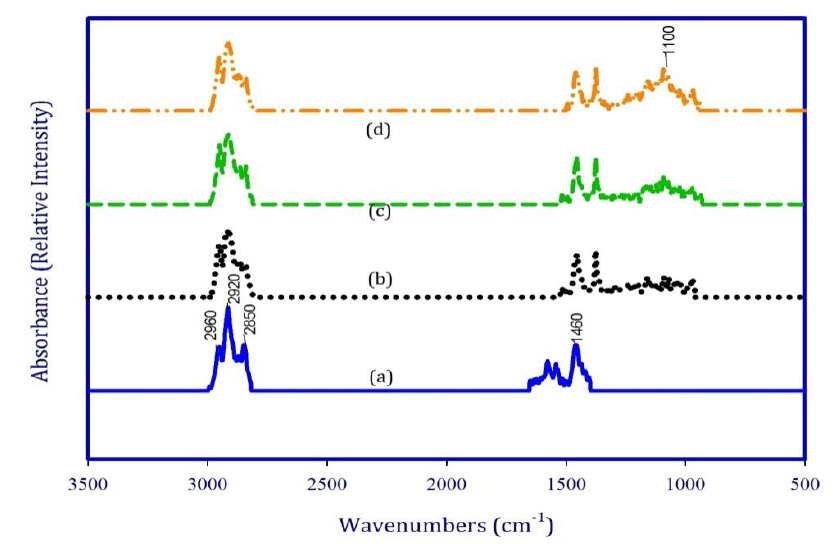
Figure 3. FTIR results for the EPC and its nanocomposites. ( a ) EPC, ( b ) EPC/SiO 2, (1%) ( c ) EPC/SiO 2, (3%), and ( d ) EPC/SiO 2 (5%).